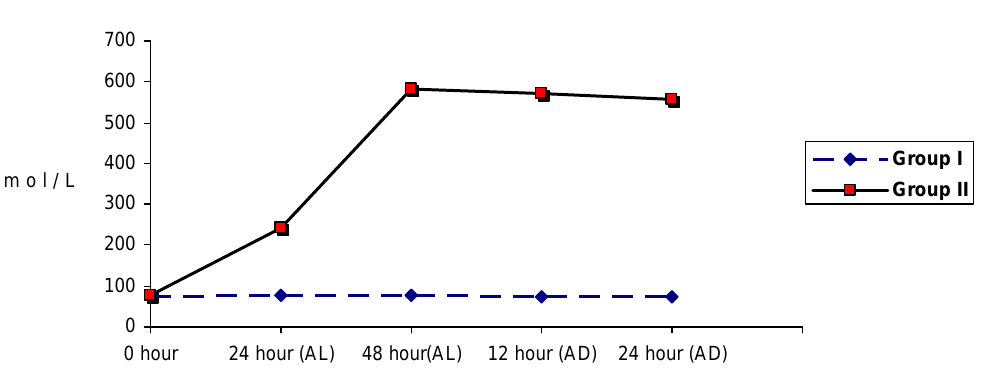
FIGURE 1 . (SERUM CREATININE): Showing the serum creatinine (µmol / L) level at different time interval. AL = after ligation, AD = after dialysis.